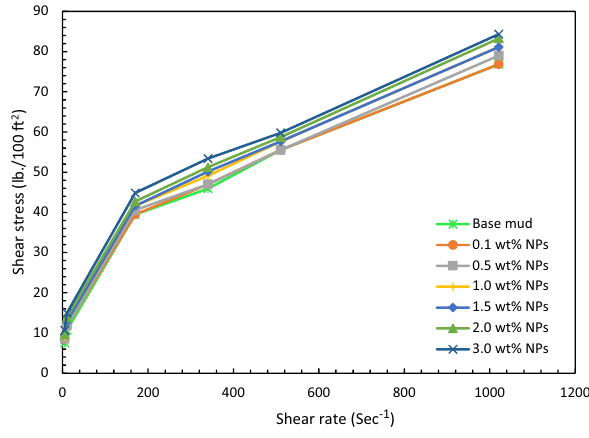
Fig. 5 Rheological behavior of mud at different NPs concentrations